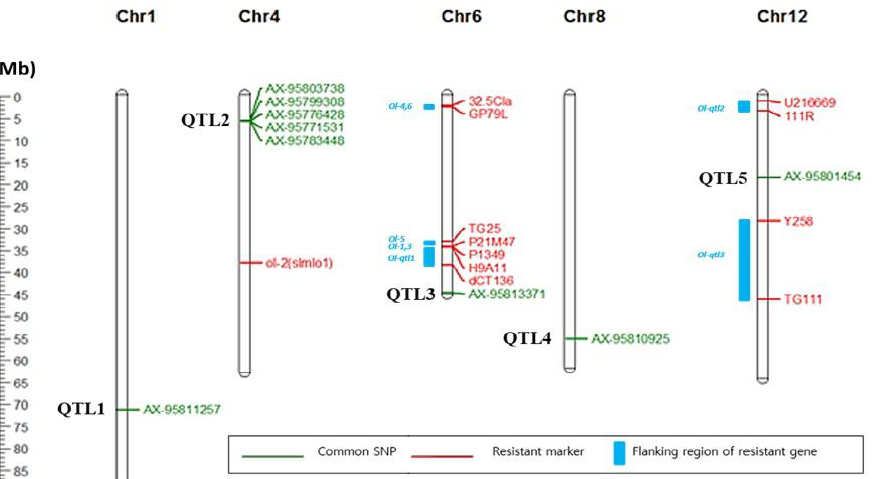
Figure 6. A schematic diagram of tomato chromosomes, with the genomic locations of the nine single nucleotide polymorphisms (SNPs, in green) significantly associated with powdery mildew resistance (PMR) in tomato depicted. The PMR loci and DNA markers identified in previous studies are shown in blue and red, respectively.